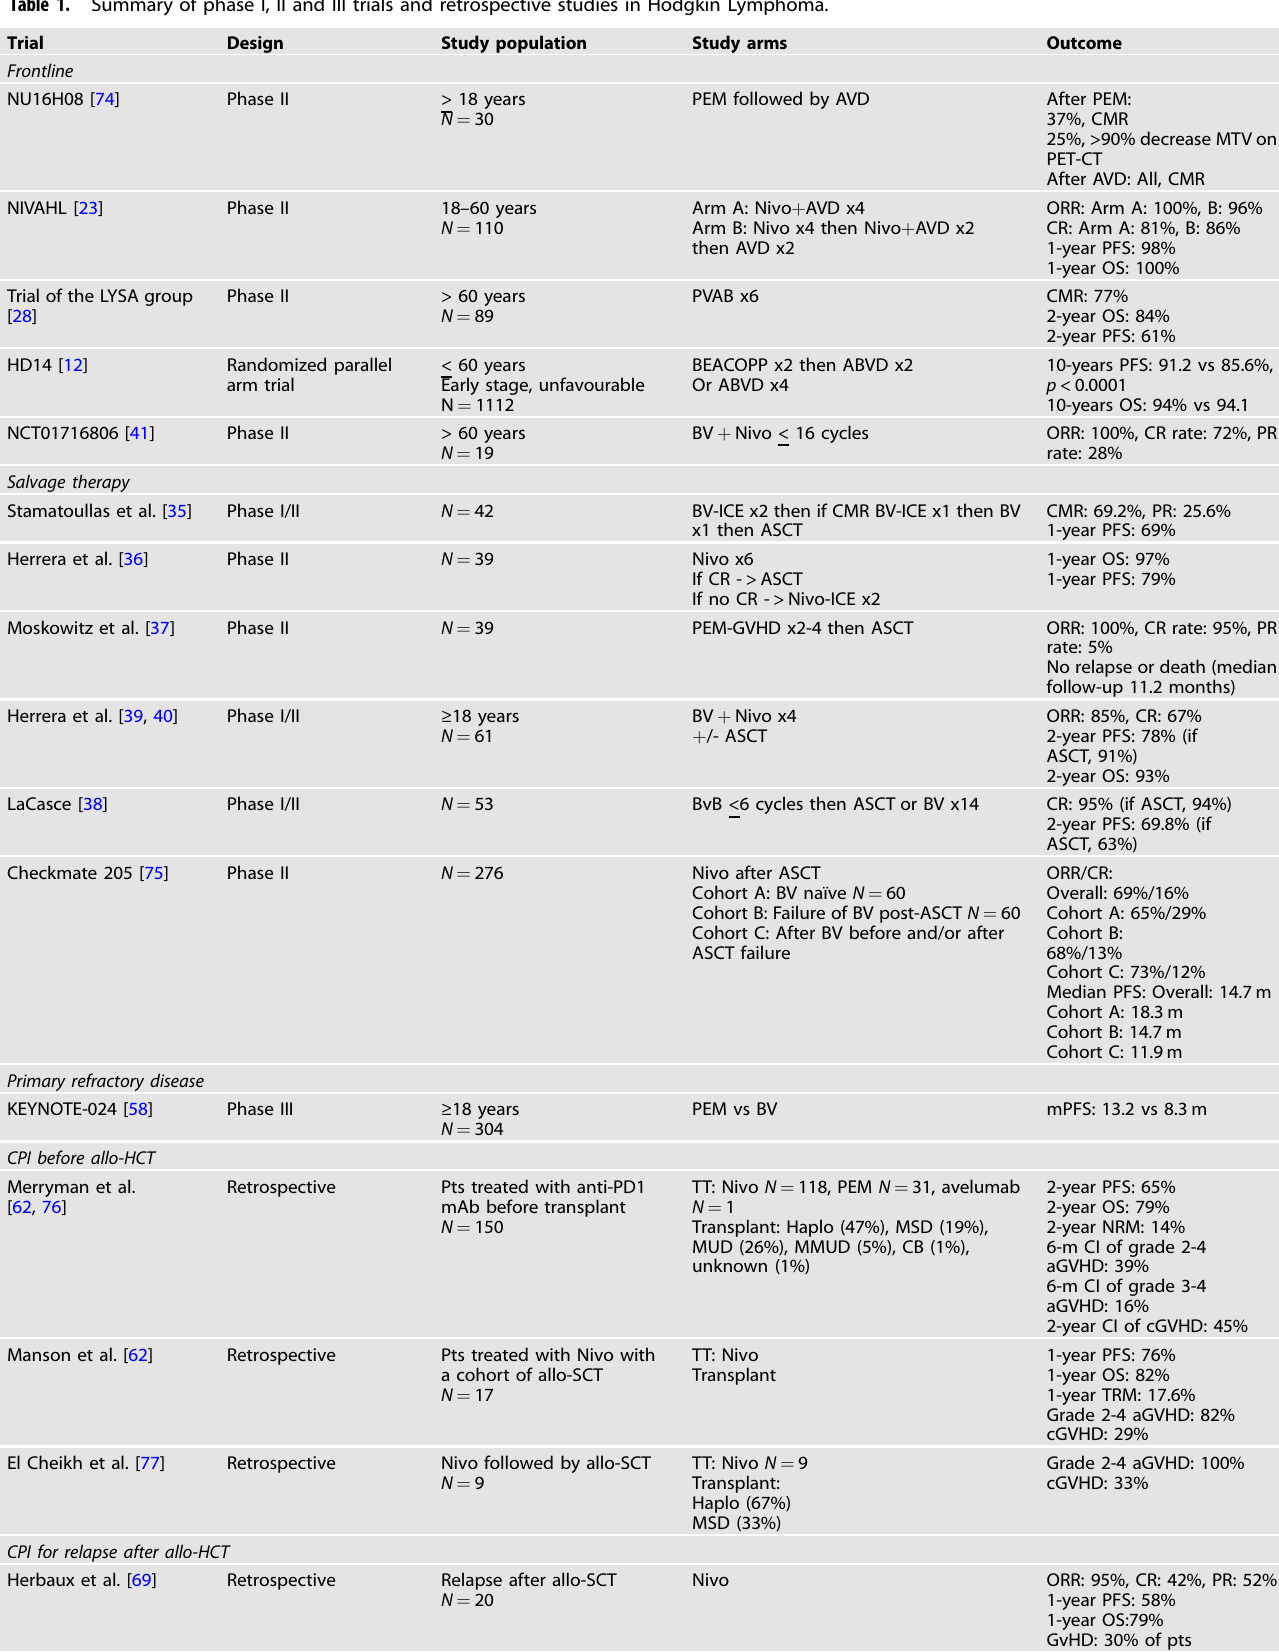
Table 1. Summary of phase I, II and III trials and retrospective studies in Hodgkin